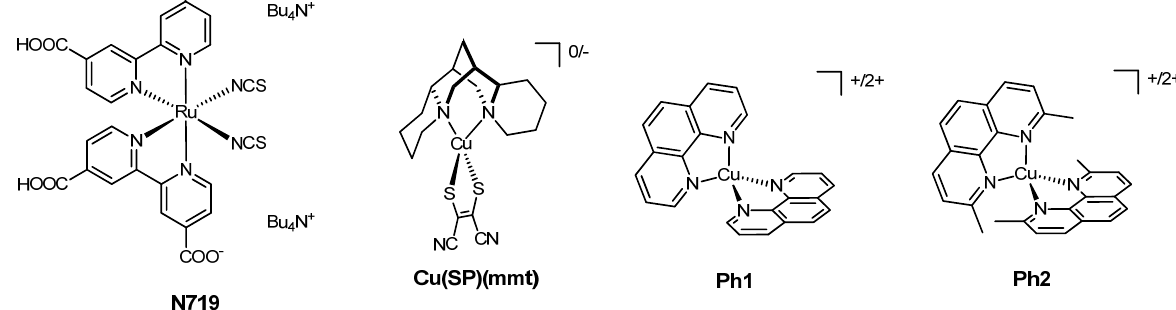
Figure 1. The dye N719 and the copper complexes used as redox mediators by Fukuzumi et al.